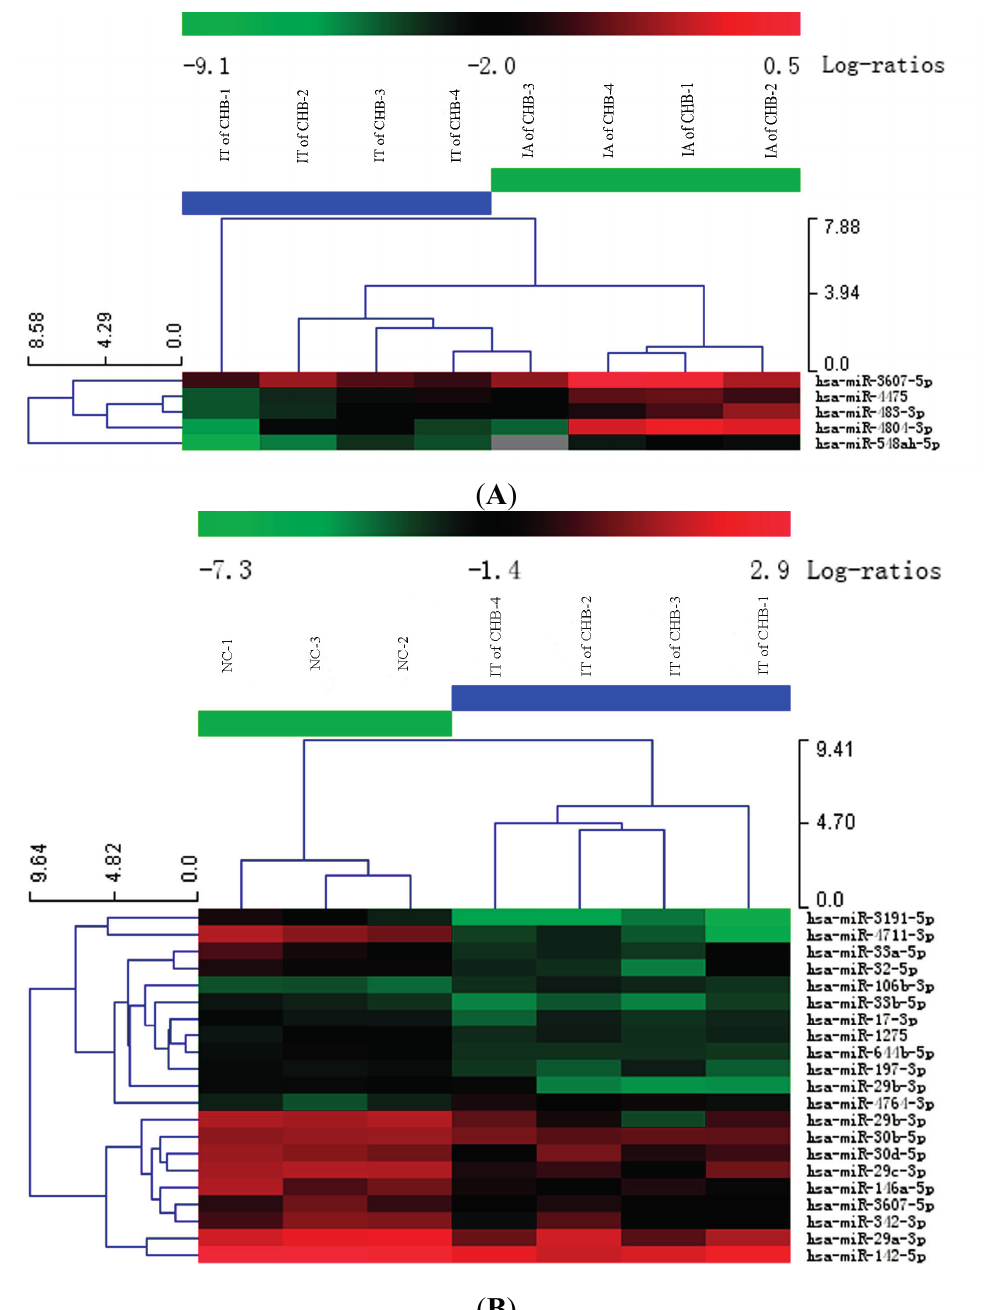
Figure 1. Hierarchical cluster analysis using total miRNA of PBMC in IA and IT stages of Chronic HBV infection. ( A ) IT of CHB vs . IA of CHB; ( B ) IT of CHB vs . NC; ( C ) IA of CHB vs . NC. Legend: IT, immune tolerance; IA, immune activation; NC, normal control; CHB, chronic hepatitis B. Note: (1) Red represents that the upregulation of miRNA; Green represents a downregulation of miRNA; (2) The PBMCs of three subjects from the same group were pooled and four or three pools were analyzed in the microarray